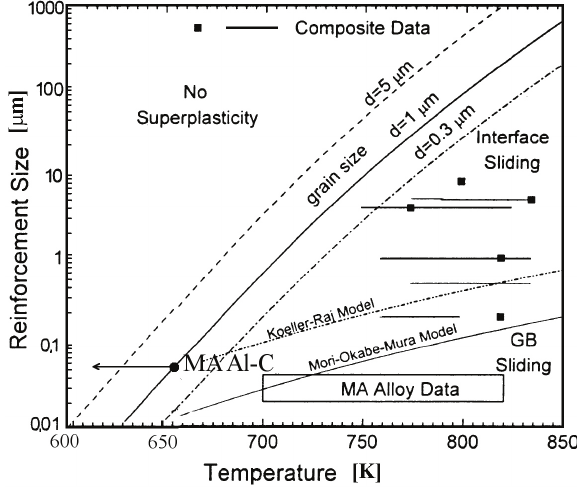
Figure 5. Superplastic behaviour layout for Al alloys.